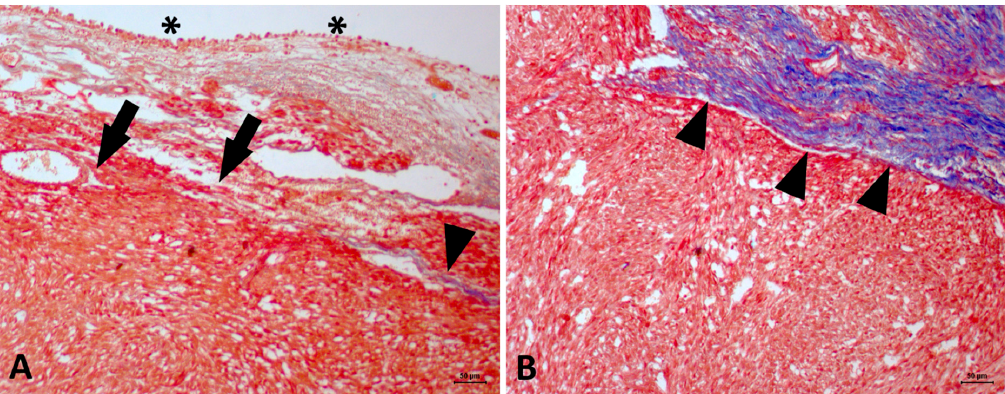
Figure 4. Feline bladder leiomyosarcoma. ( A ) Red staining in normal mucosa (urothelial epithelium, asterisk) and of tumor cells (black arrows) is shown, supporting the leiomyosarcoma diagnosis. The remaining collagen fibers are stained in blue (arrowhead). ( B ) Contrast between the blue staining of the collagen fibers (arrowhead) and the red staining of the tumor cells. Masson's trichrome stain, original magnification 20×.